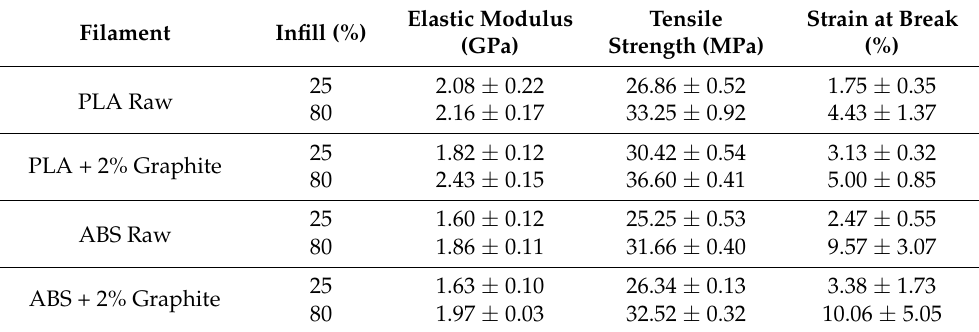
Table 7. Tensile results to assess filaments’ printability using the PRUSA I3 MK3S printer without laser heating.